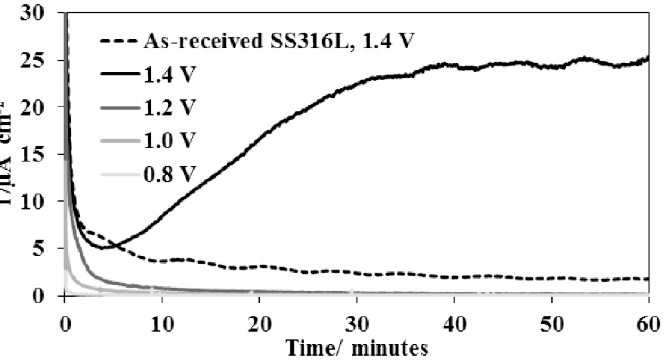
Figure 18. Current density dependence on applied potential for 316L steel with TiN coating in 1 mM H 2 SO 4 . Reprinted from [23] copyright (2010), with permission from Elsevier.